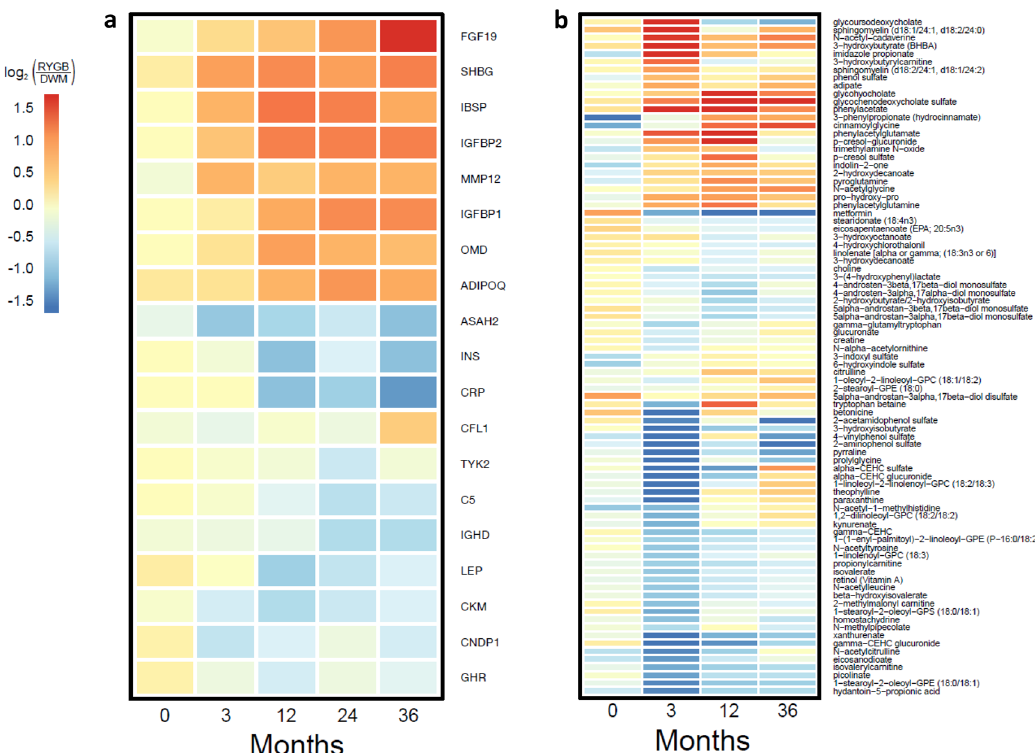
Fig. 2 Differentially abundant analytes with time. Heatmaps of a proteins and b metabolites. Heatmap of log 2 (RYGB/DWM) at all time points (post- baseline log 2 abundance values are baseline-corrected) for analytes that are differentially abundant at any time point (FDR < 0.15 and fold-change absolute value > 1.5). The range of colors show log 2 (RYGB/DWM) from − 1.6 to 1.6, which corresponds to fold changes from − 3 to 3. Analytes with a larger absolute value of fold-change are shown as only having fold change absolute value of 3, so that weaker fold changes are easily observed. Source data are provided as a Source Data fi